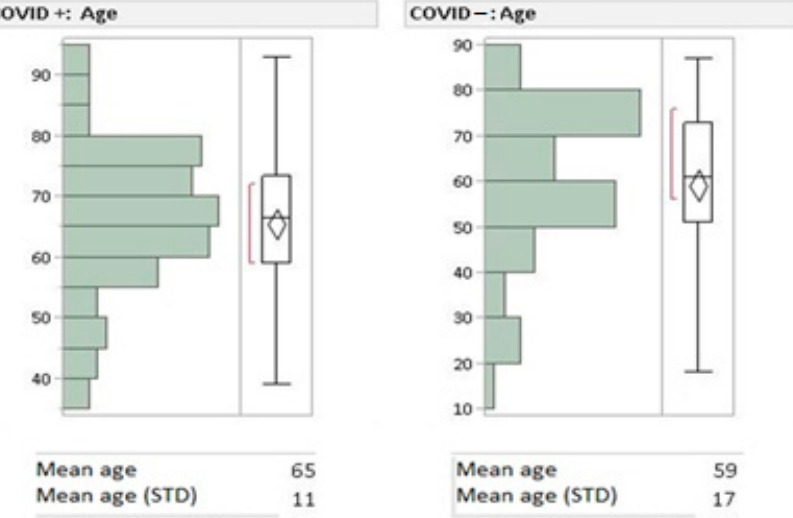
Figure 1. Population mean age and standard deviation (STD).